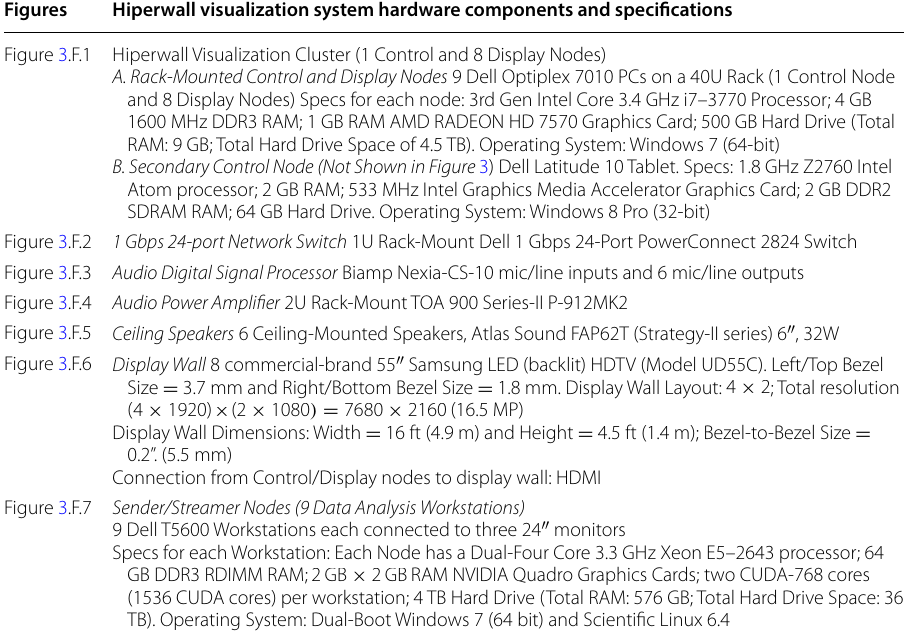
Table 2 Hiperwall visualization system hardware components and specifications as shown in Fig. 3